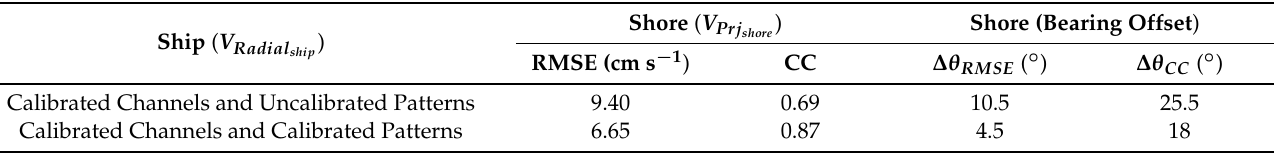
Table 4. Comparison statistics with respect to the shore using the uncalibrated and calibrated patterns at